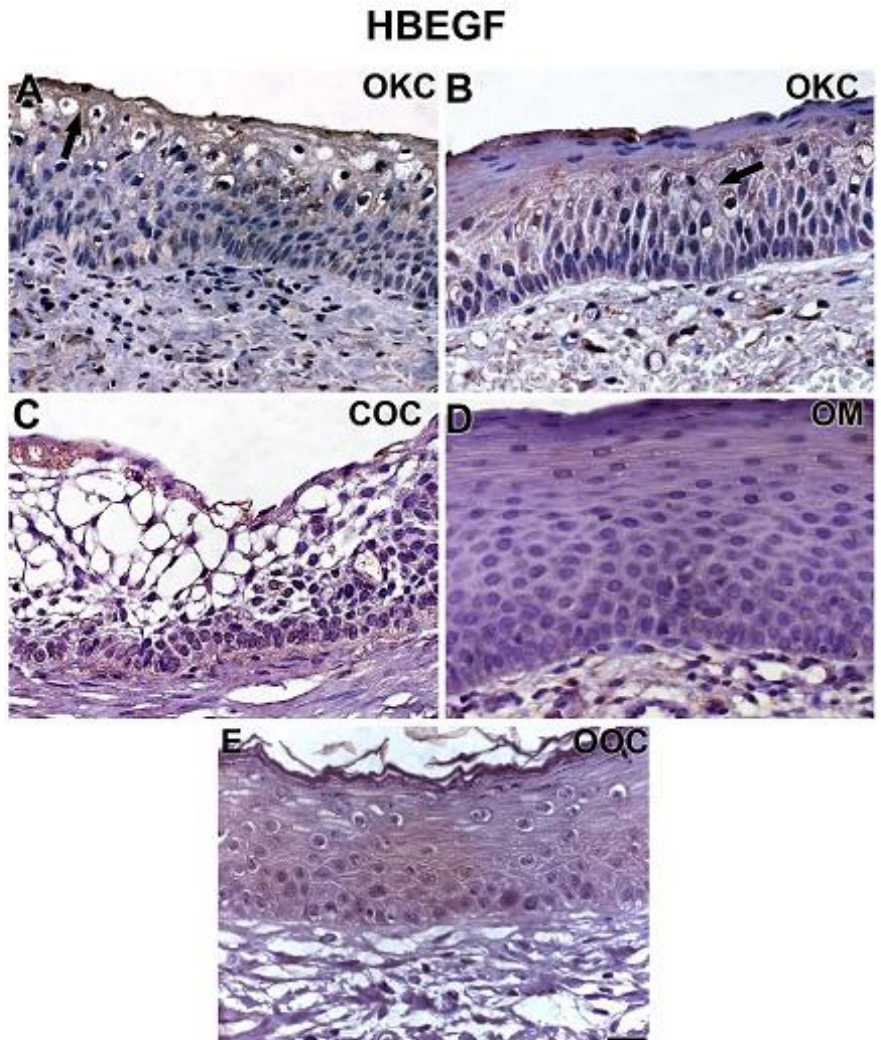
Figure 4. Immunolabelling of HBEGF in OKC ( A , B ), COC ( C ), OM ( D ), and OOC ( E ). Generally speaking, HBEGF expression resembled the pattern observed with ADAM-12 for all groups. HBEGF was expressed in the cytoplasm of all epithelial strata ( A , B ), especially in the periphery of the cytoplasm ( A , B , arrows). There was an even distribution in all the epithelial layers. HBEGF expression in COC was predominantly cytoplasmic, with no expression in ghost cells ( C ). In OM samples, immunostaining was seen in the cytoplasm of the basal and predominantly in lower cells of the parabasal layers ( D ). HBEGF was predominantly found in the cytoplasm of basal cells in OOC; however, its expression was weak in parabasal layers ( E ). Scale bar: 20 µm.